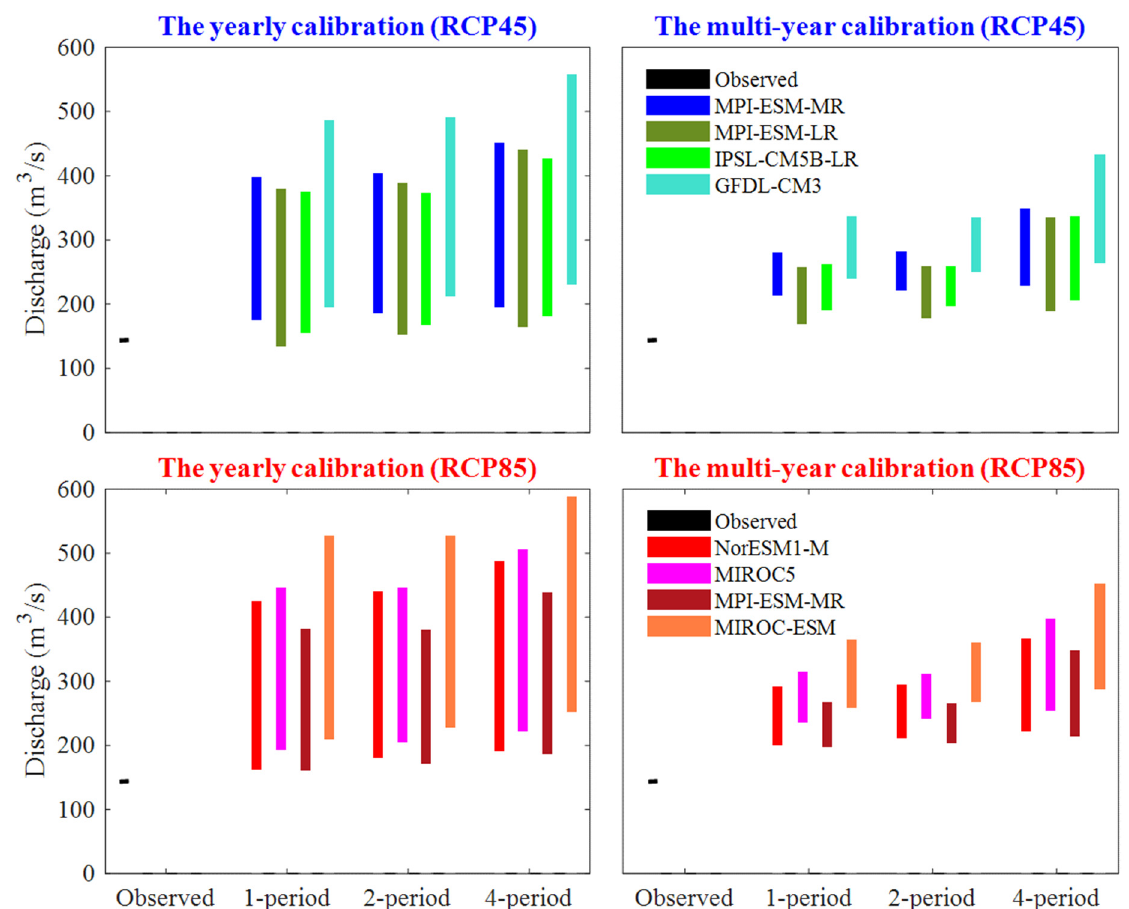
Figure 9. The 95% confidence intervals for the GCM–SRM predicted average discharge of the snowmelt season (Period 2041–2050). The bottom and top of the colored bars represent the 2.5th and 97.5th percentile values, respectively. The black bar represents the average snowmelt season discharge during 2003–2012.